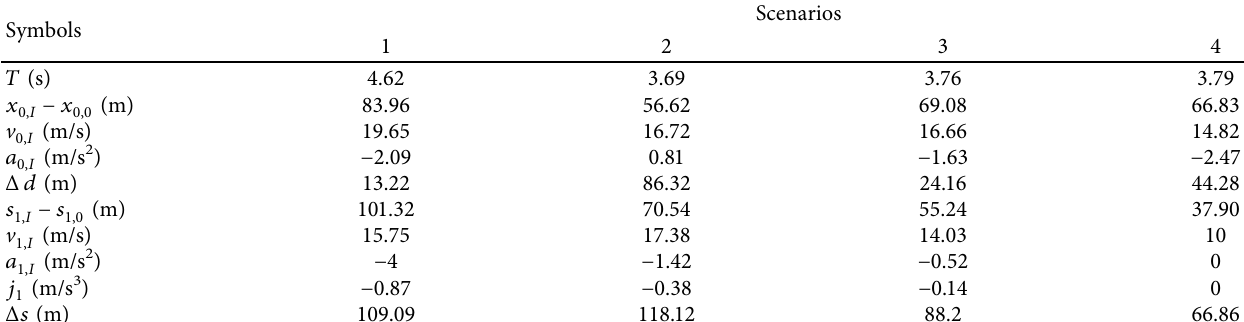
Table 5: Trajectory planning results for test